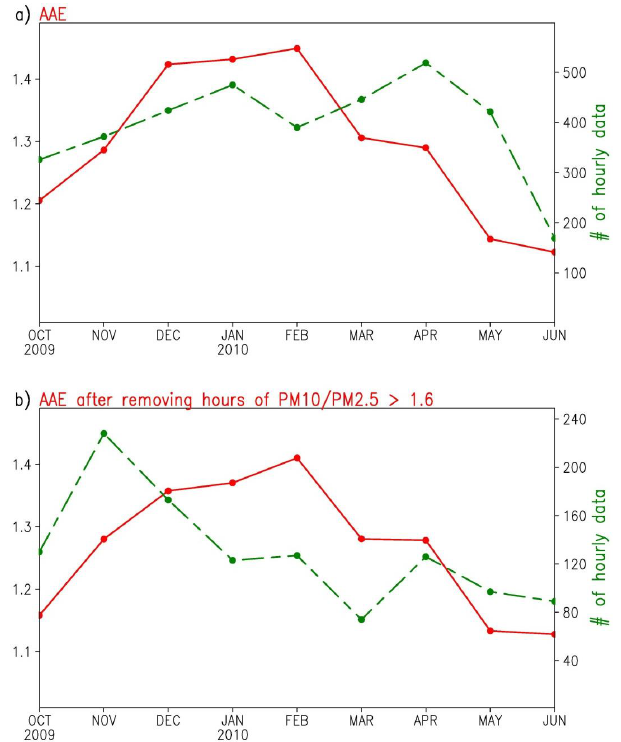
Figure 6. Monthly-mean AAE at Gosan. Fig. 6. Monthly-mean AAE at